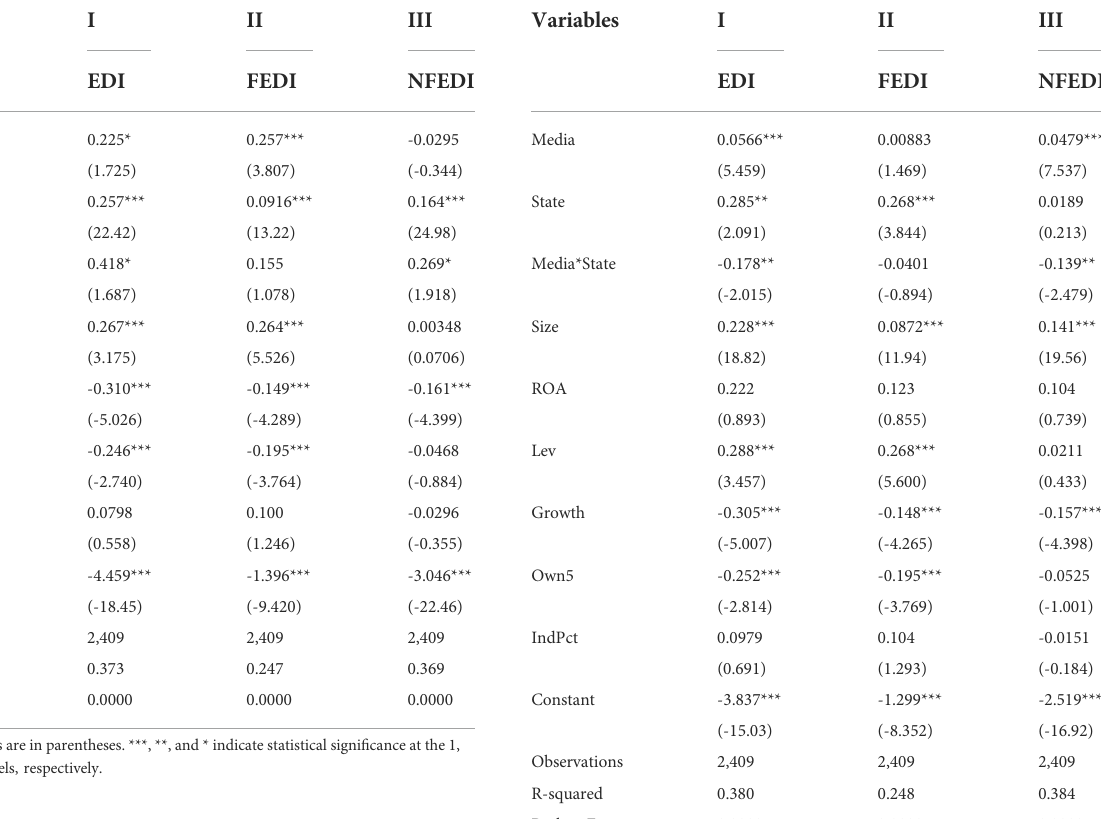
TABLE 6 Regression results of State and EDI. TABLE 7 Regression results of Media, State, and